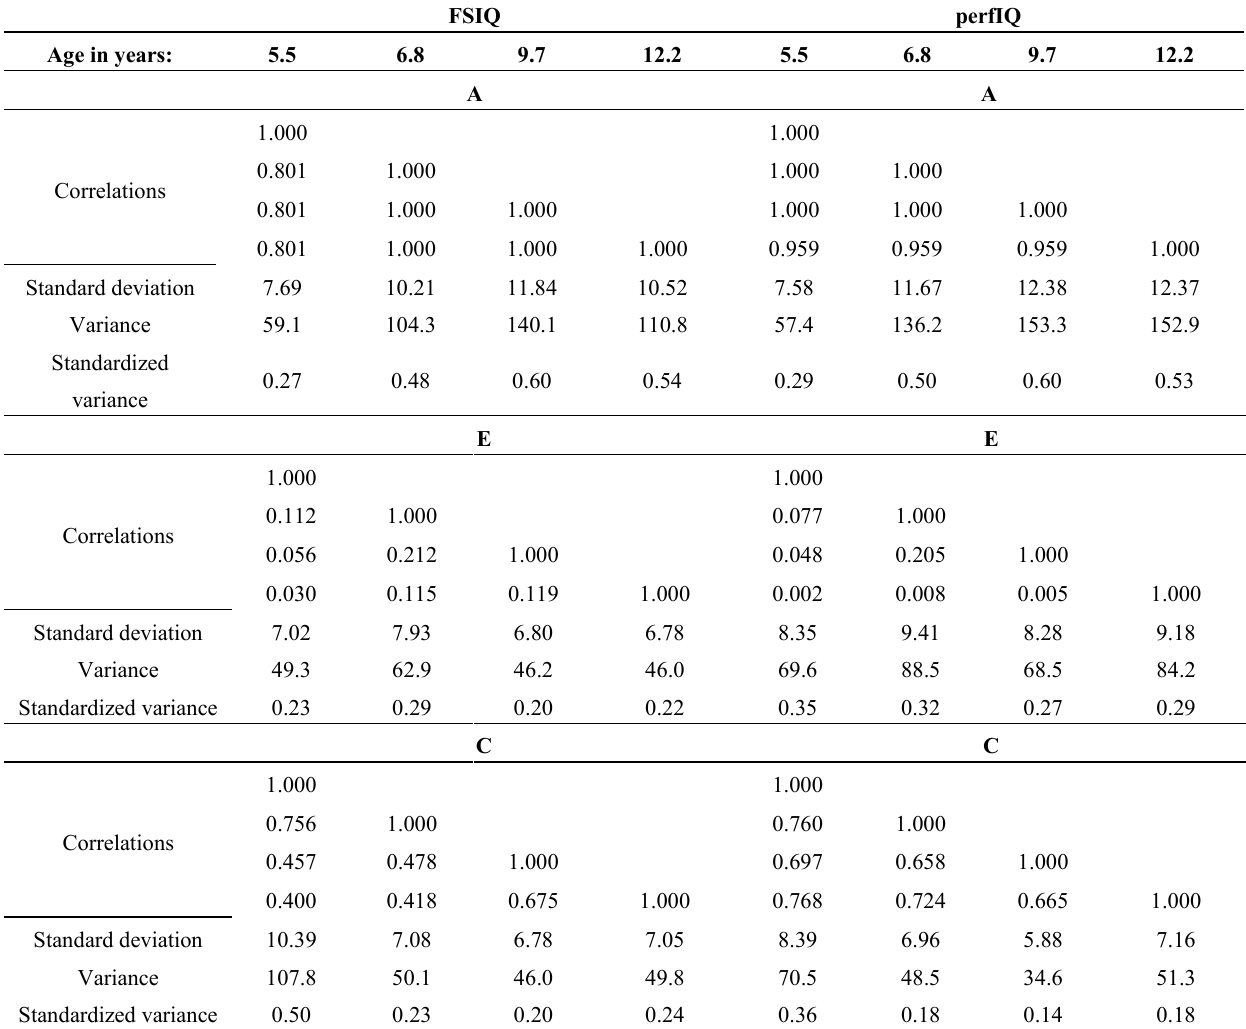
Table 1. Standard ACE simplex model results of full scale IQ (FISQ) and performance IQ (perfIQ): Correlations among A, E, and C, standard deviations, variances and standardized variance. Note in this model A, C, and E are uncorrelated. FSIQ perfIQ Age in years: